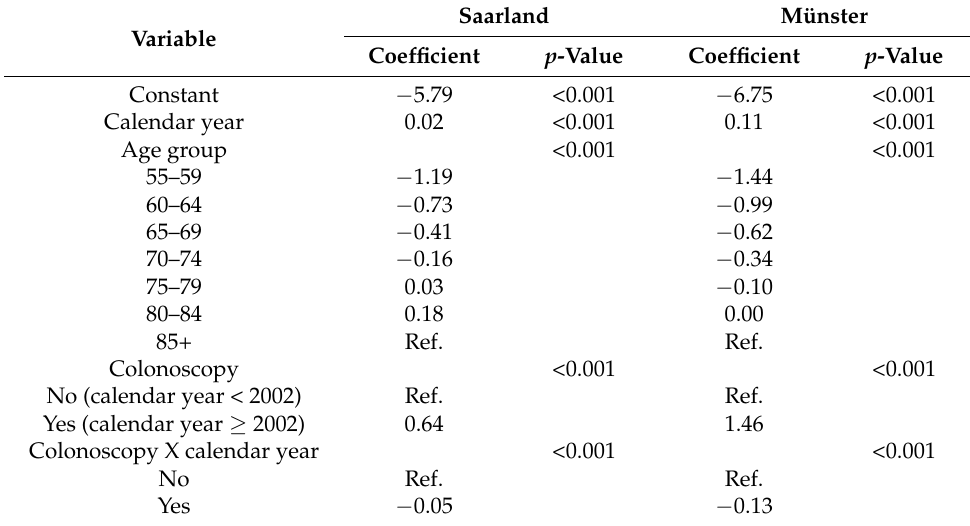
Table A1. Poisson regression for modeled incidence rates displayed in Figure 1, non-young-onset